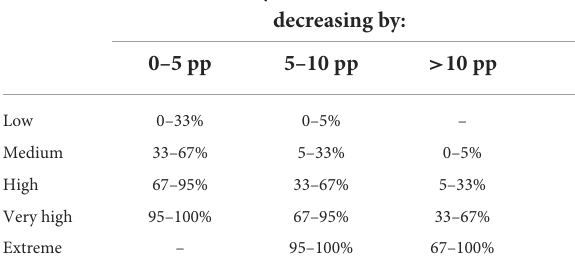
TABLE 2 Definitions of climate risk levels for the